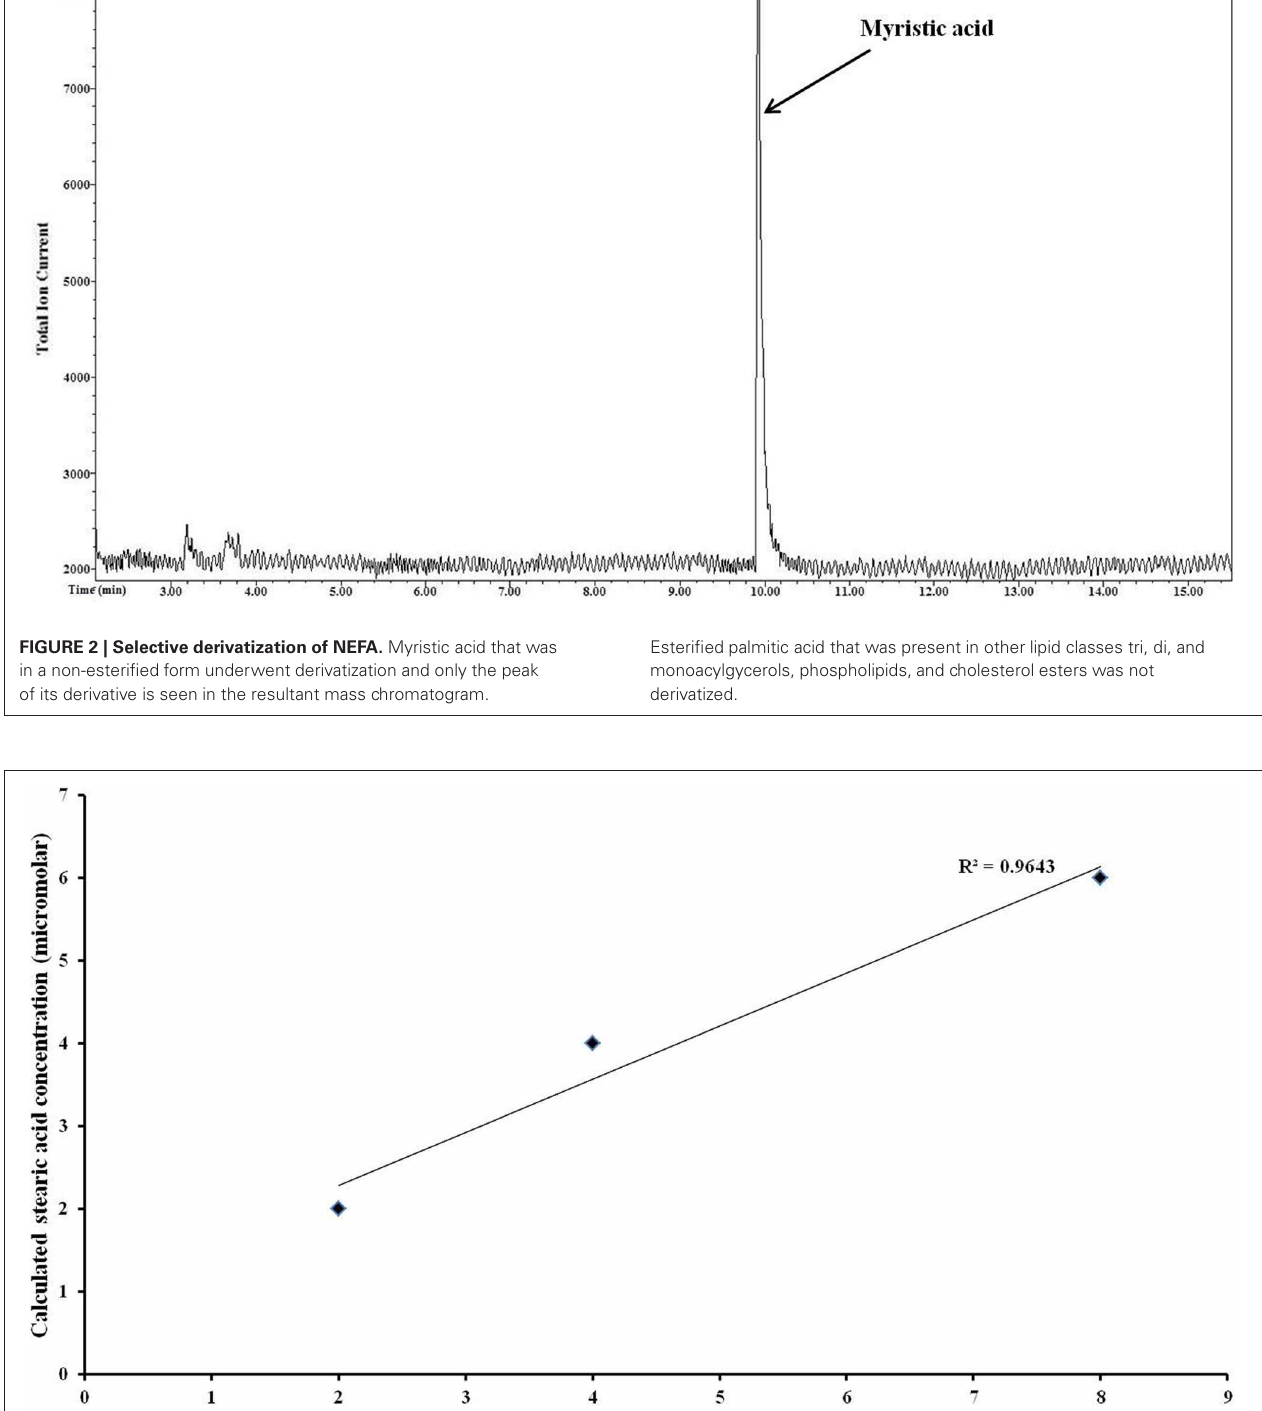
FIGURE 3 | Linearity of the quantitative analysis. High linear correlation was observed between actual values of stearic acid concentration and its corresponding calculated values.